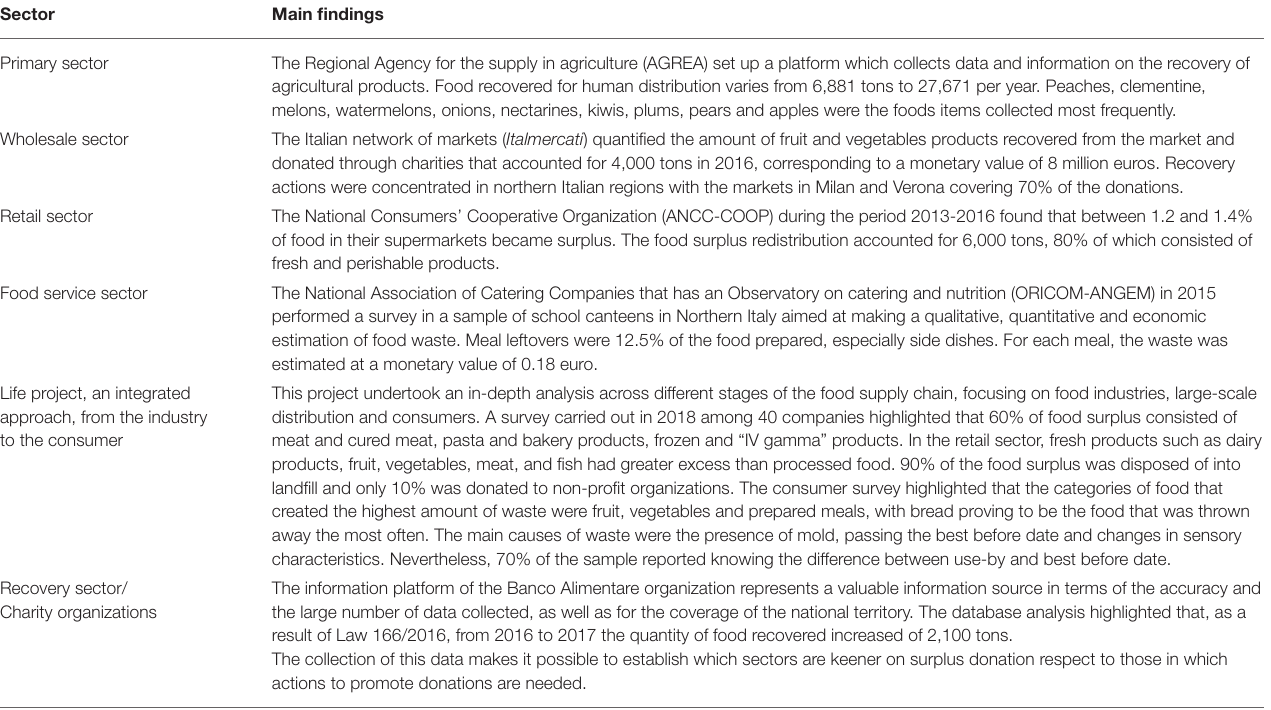
TABLE 1 | Assessment of actions and projects related to the food loss and waste in Italy as a benchmark of the OERSA development.